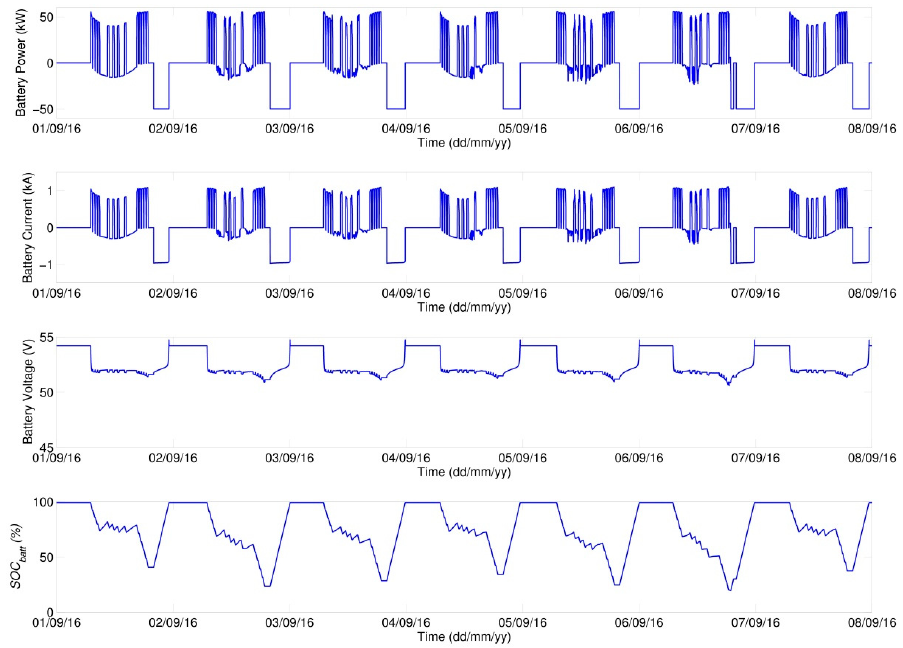
Figure 16. Resulting profiles of simulation of operating states of accumulation, scenario A.